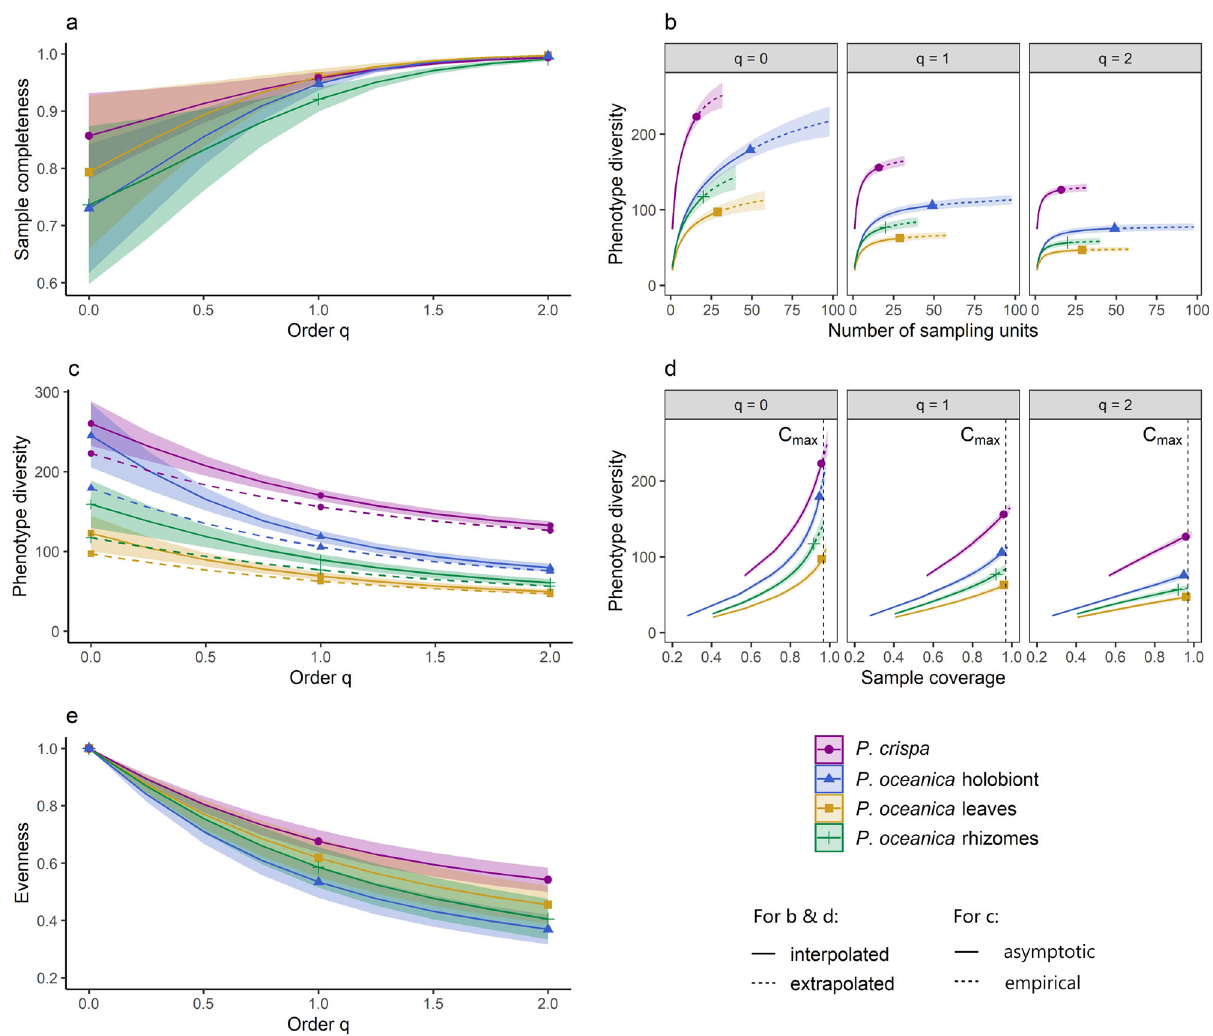
Fig. 3 Overview of biodiversity analysis based on Hill numbers. a Estimated sample completeness curves as a function of order q between 0 and 2. b Size-based rarefaction (solid lines) and extrapolation (dashed lines) curves up to double the respective sample size. c Asymptotic estimates of diversity pro fi les (solid lines) and empirical diversity pro fi les (dashed lines). d Coverage-based rarefaction (solid lines) and extrapolation (dashed lines) curves up to double the reference sample size. Vertical dashed lines show the standardised sample coverage C max = 96.6%. e Evenness pro fi les as a function of order q , 0 < q ≤ 2, based on the normalised slope of Hill numbers. Dots ( P. crispa ), triangles ( P. oceanica holobiont), rectangles ( P. oceanica leaves) and crosses ( P. oceanica rhizomes) denote observed data points. All shaded areas in a – e denote 95% con fi dence intervals obtained from a bootstrap method with 500 replications. Note: some bands are invisible due to narrow